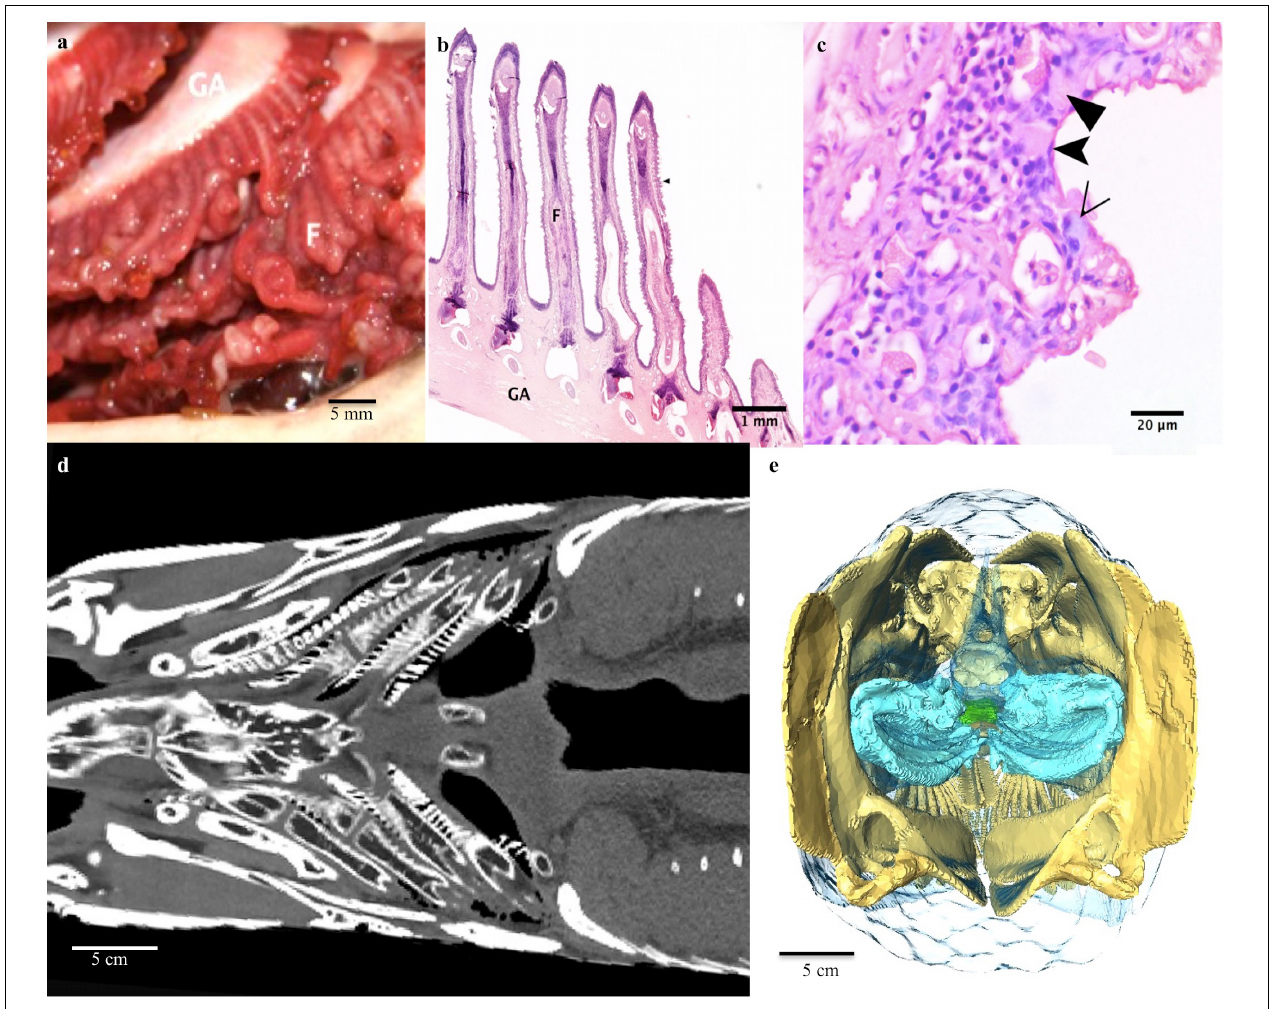
FIGURE 2 | Respiratory system: The gill arches and filaments. (a) On each side there are four gill arches (GA) with associated cartilaginous filaments (F). (b) Photomicrograph of the boney gill arch, cartilaginous filaments. Note extensive blunting and broadening of the lamellae. (c) A higher magnification light micrograph of the lamellae of a gill filament. The epithelium of the lamellae is made up of ionocytes (filled arrowheads), mucocytes (empty arrowhead) and pavement cells (notched arrowhead). Note the collapse of the pillar cell system. (d) Coronal CT slice at level of the base of mouth demonstrating the gill arches and filaments. (e) 3D reconstruction of gill arches (blue) from CT as seen from caudal end of fish looking cranially into the